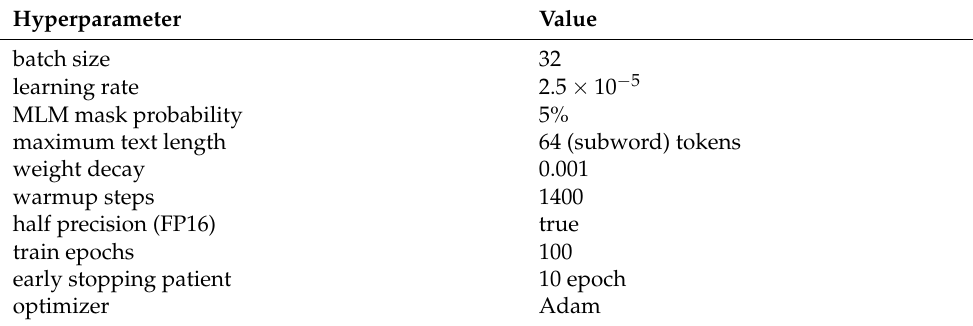
Table 1. The hyperparameters for LM-finetuning.